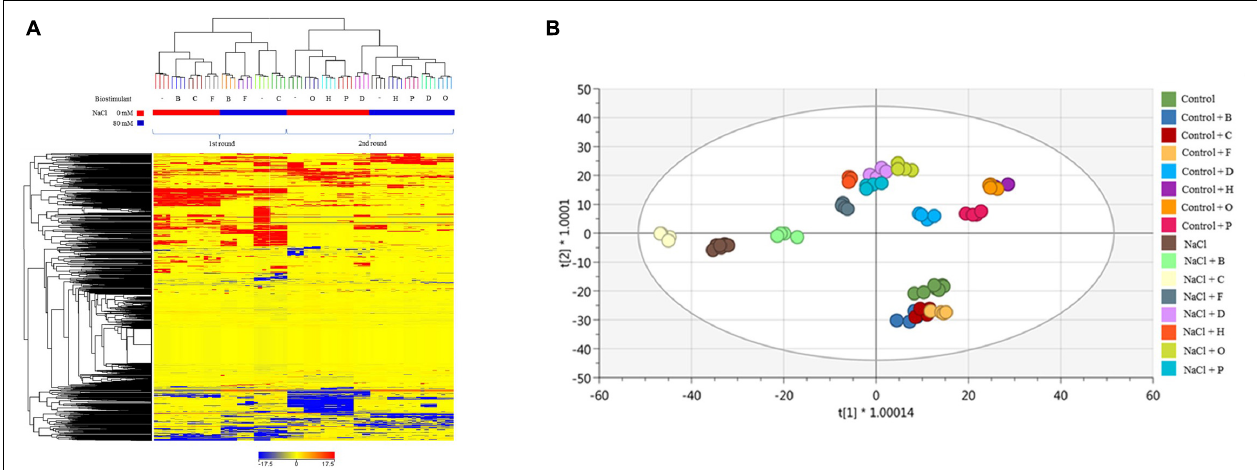
FIGURE 5 | Metabolomic analysis of lettuce plants. Unsupervised hierarchical cluster analysis carried out from ultra-high-pressure liquid chromatographic system (UHPLC-ESI/QTOF-MS) metabolomics analysis of lettuce plants treated with 7 PHs under control and salt stress (NaCl) conditions. The fold-change-based heat map was used to build hierarchical clusters (linkage rule: Ward, distance: Euclidean) (A) . Score plot of orthogonal projection to latent structures discriminant analysis (OPLS-DA) supervised modelling carried out on untargeted metabolomics profiles of lettuce plants after 7 PHs application, under control and salt stress (NaCl) conditions (R2Y = 0.98, Q2Y = 0.93) (B) .